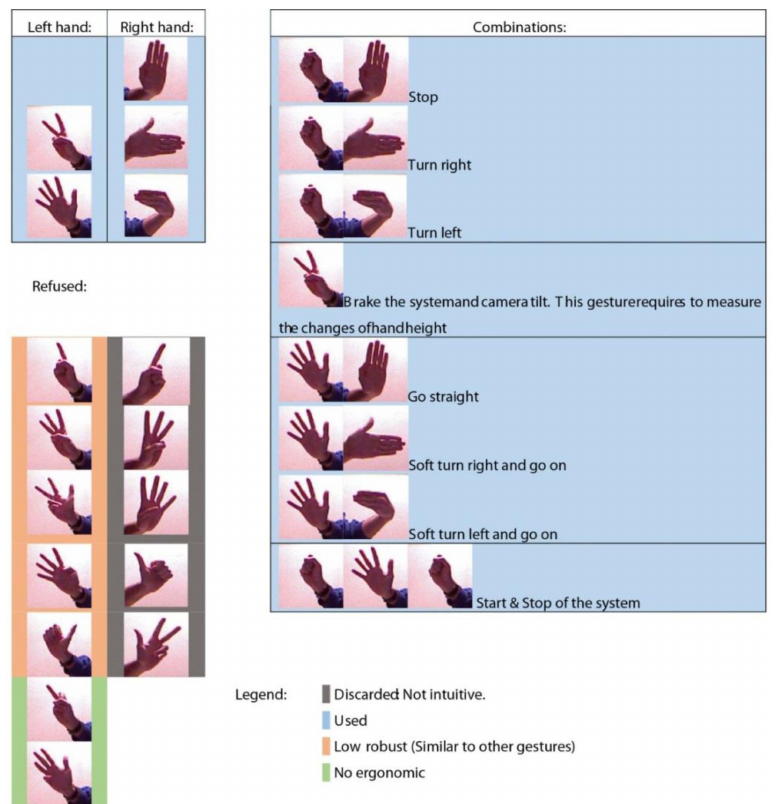
Figure 19. Gestures considered for robot control in our experiments.